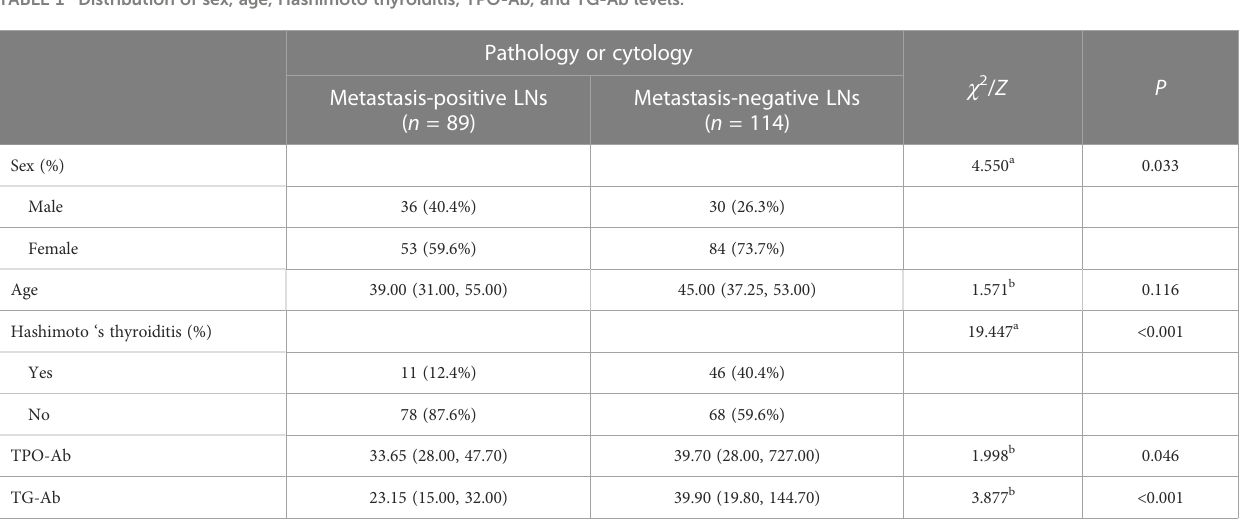
TABLE 1 Distribution of sex, age, Hashimoto thyroiditis, TPO-Ab, and TG-Ab